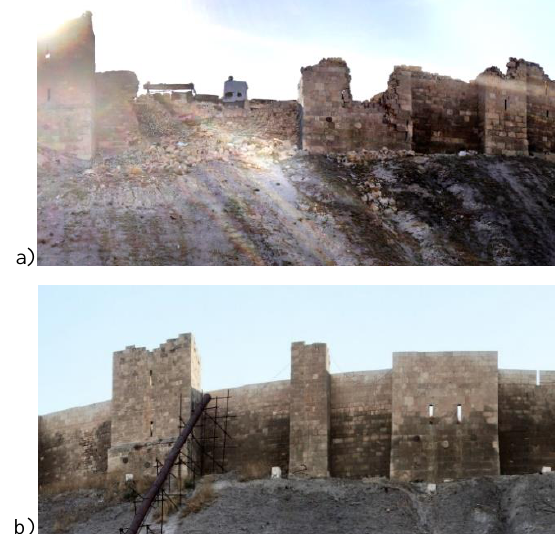
Figure 4. Citadel walls, current situation (a) and how it was in 2010 (b). A large brech is visible, produced by